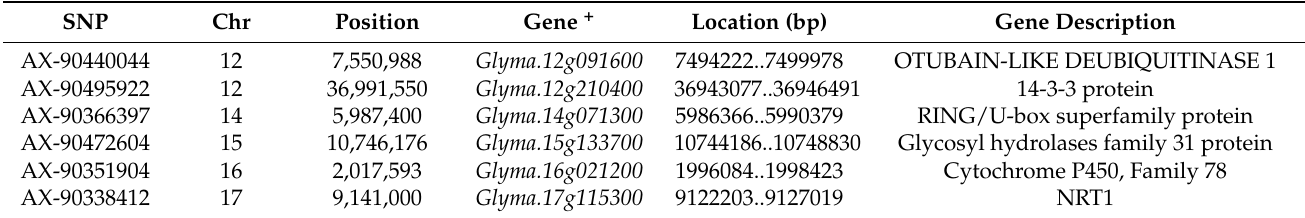
Table 6. Candidate genes associated with DtM in wild soybean.